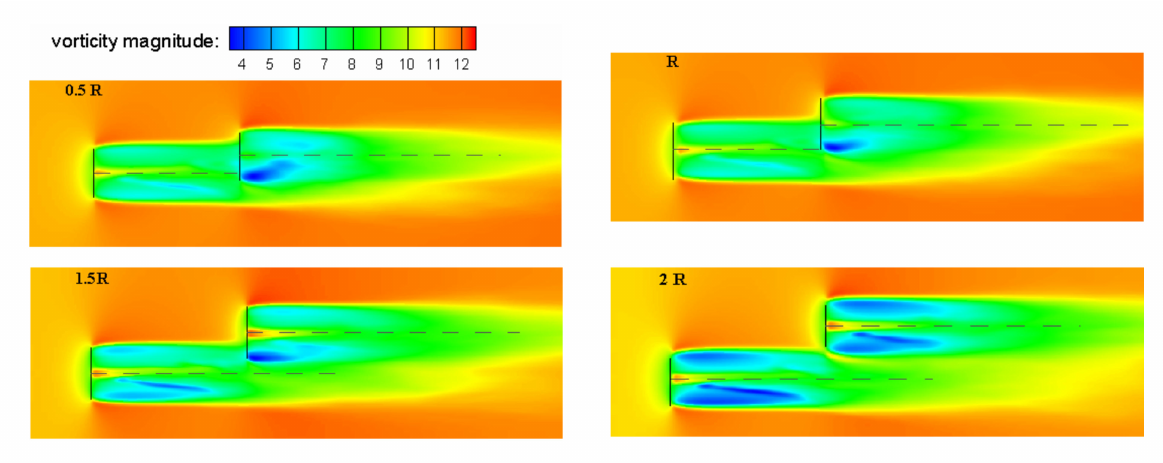
Figure 10. Mean streamwise velocity component of the horizontal section of the wind turbine center. The model turbine rotor is the sketched black line, and the dotted line represents the wake flow